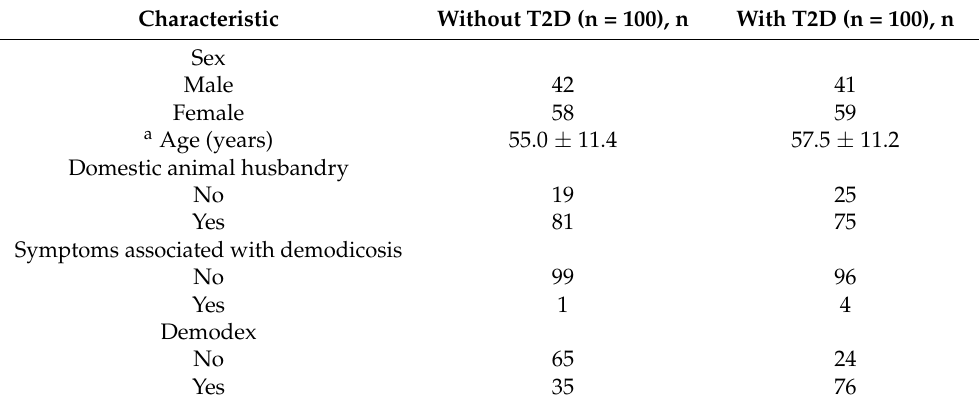
Table 1. Descriptive characteristics of the study sample with or without Type 2